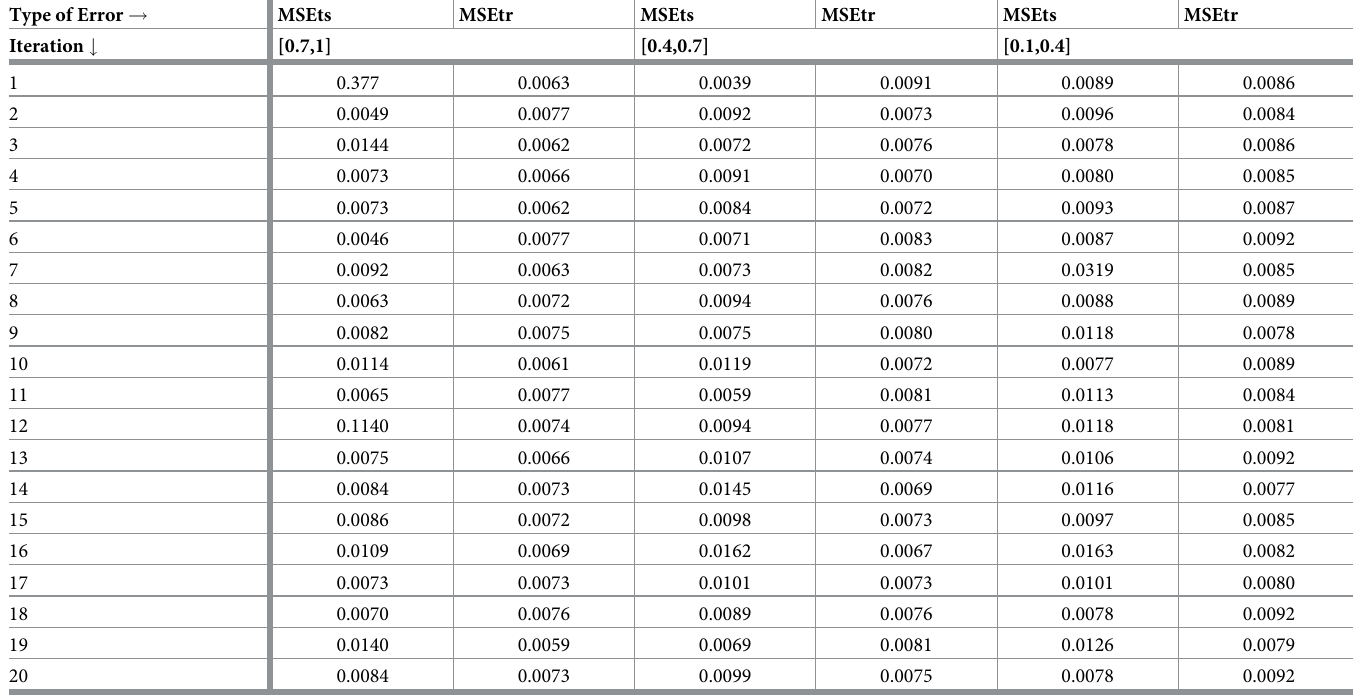
Table 2. The results of the sum of the squared error in 20 implementation of ANN-PSO network in three ranges of [0.1, 0.4], [0.4, 0.7], [0.7,